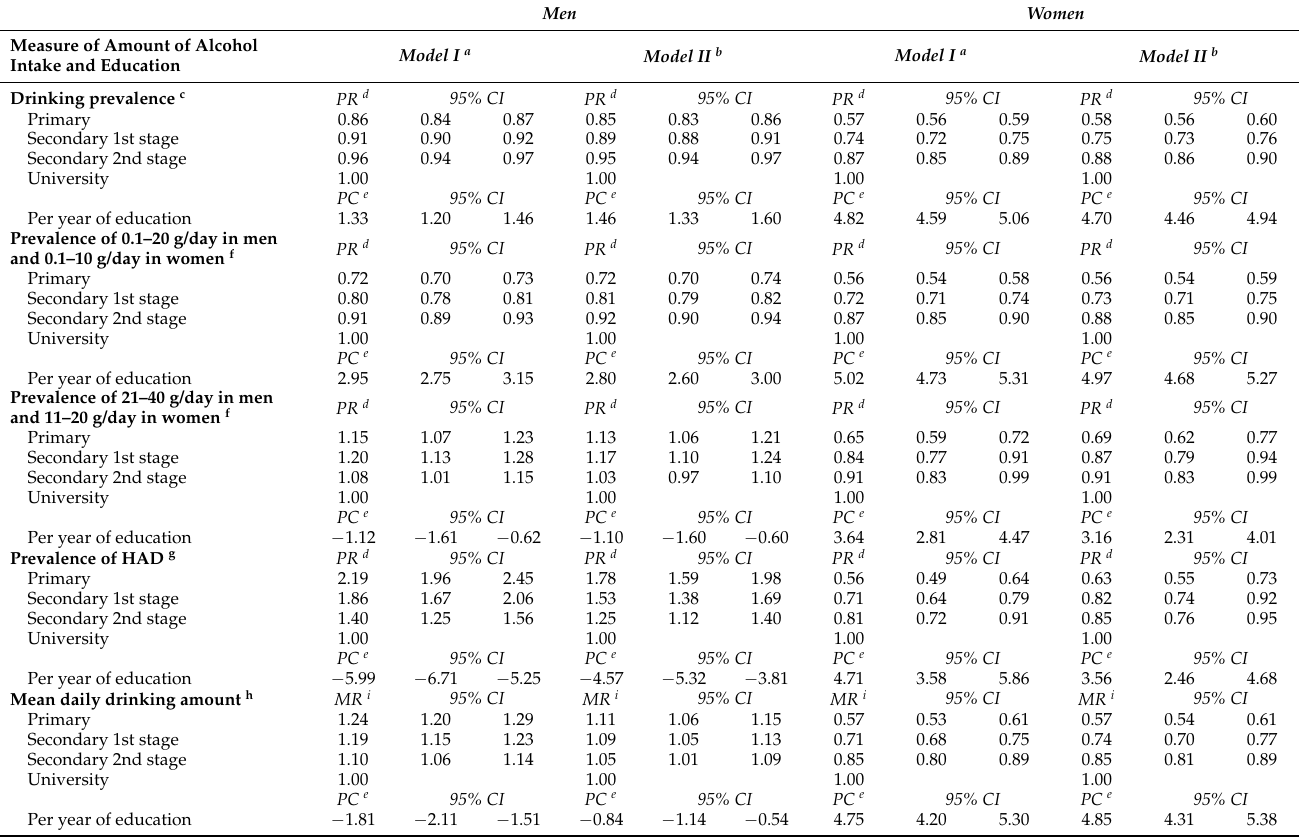
Table 2. Educational inequality in five measures of drinking amount in the last 30 days among people aged 25–64 by sex, Spain 1997–2017. Men Women Model II b Model I a Model II